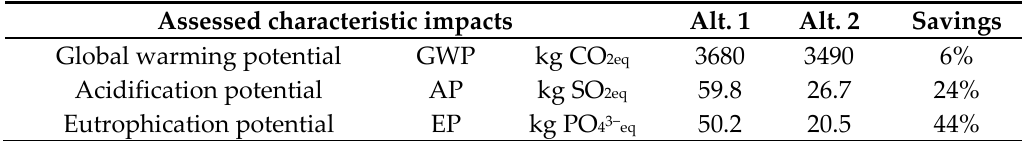
Table 4. Characteristic impacts on m 2 of the total floor area of a family